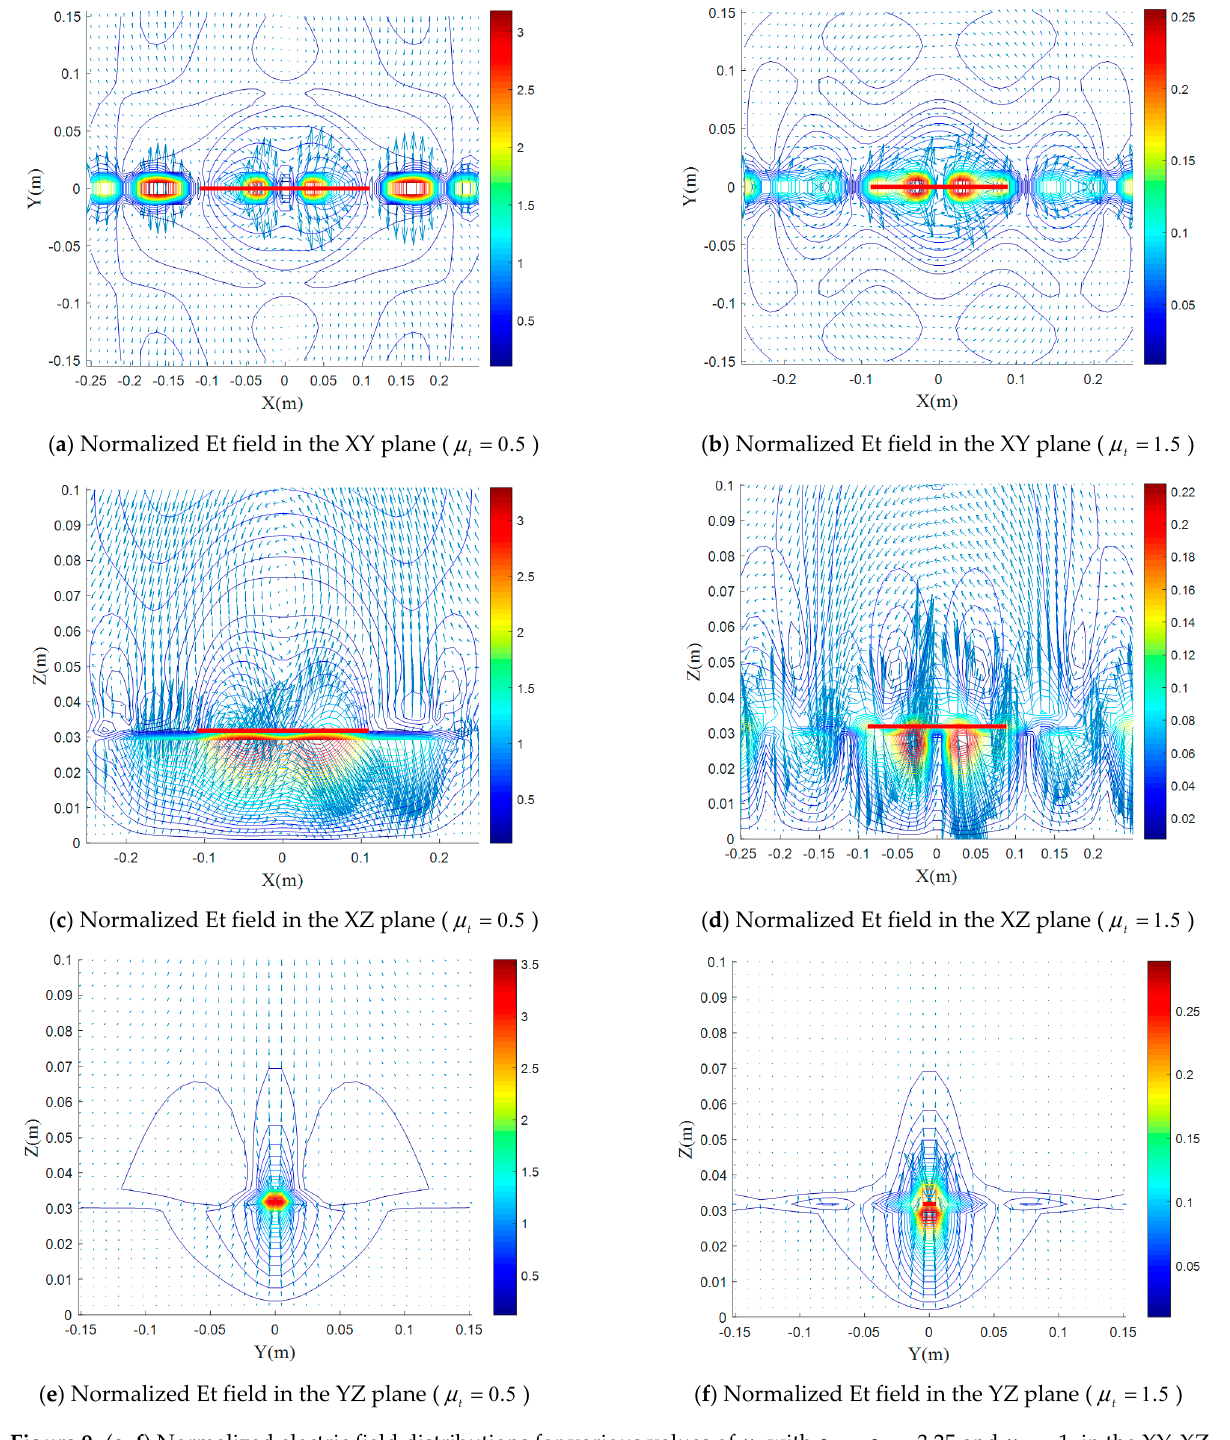
Figure 9. ( a – f ) Normalized electric field distributions for various values of µ t with ε z = ε t = 3.25 and µ z = 1, in the XY, XZ, and YZ planes.